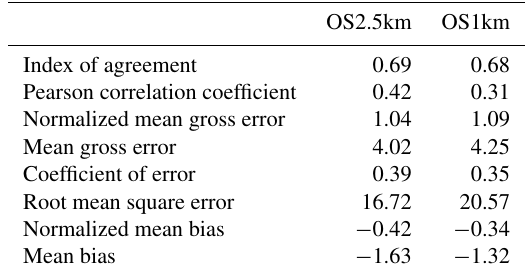
Table 7. Standard performance evaluation of Flight 8 for SO 2 (ppbv, 1261 model–observation pairs).